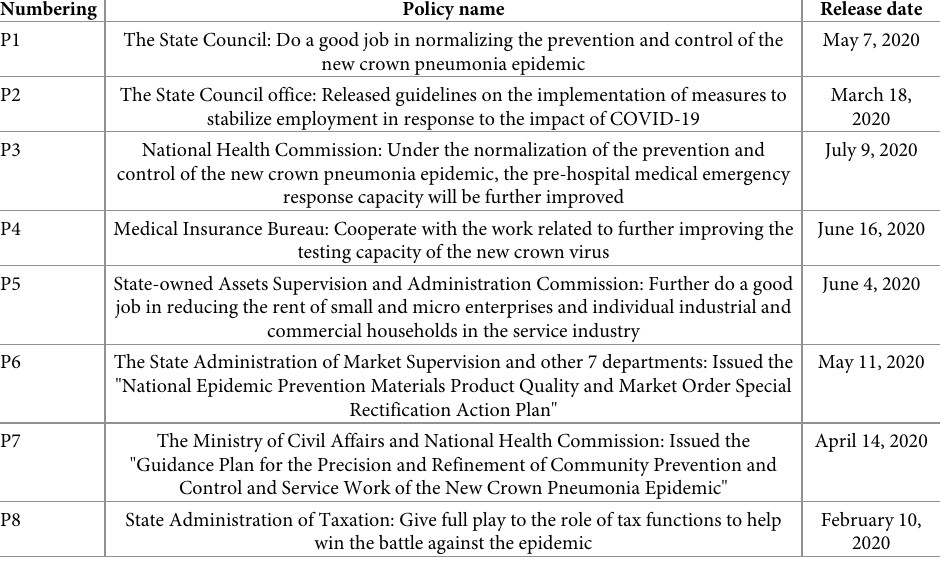
Table 1. Eight representative